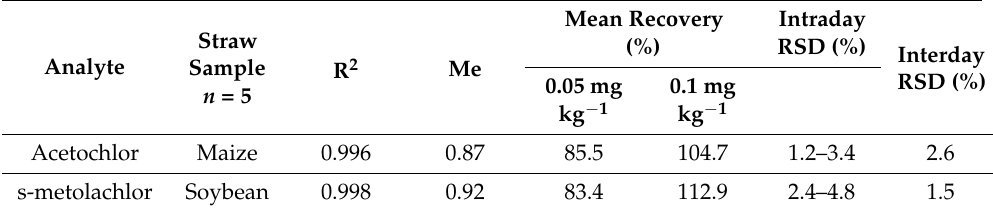
Table 3. The mean recovery, matrix effect (Me) and relative standard deviations (RSDs) of acetochlor and